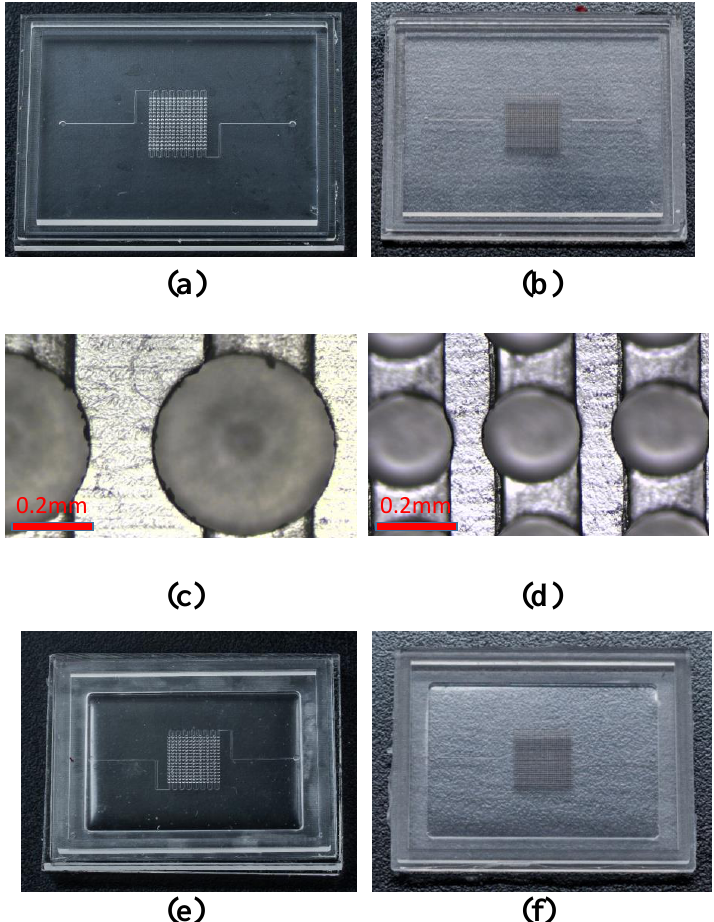
Figure 4. ( a ) Micromilled PMMA mold based on Design I; ( b ) micromilled PMMA mold based on Design II; ( c ) enlarged top-view image of ( a ); ( d ) enlarged top-view image of ( b ); ( e ) PDMS mold cast from ( a ); and, ( f ) PDMS mold cast from ( b ).